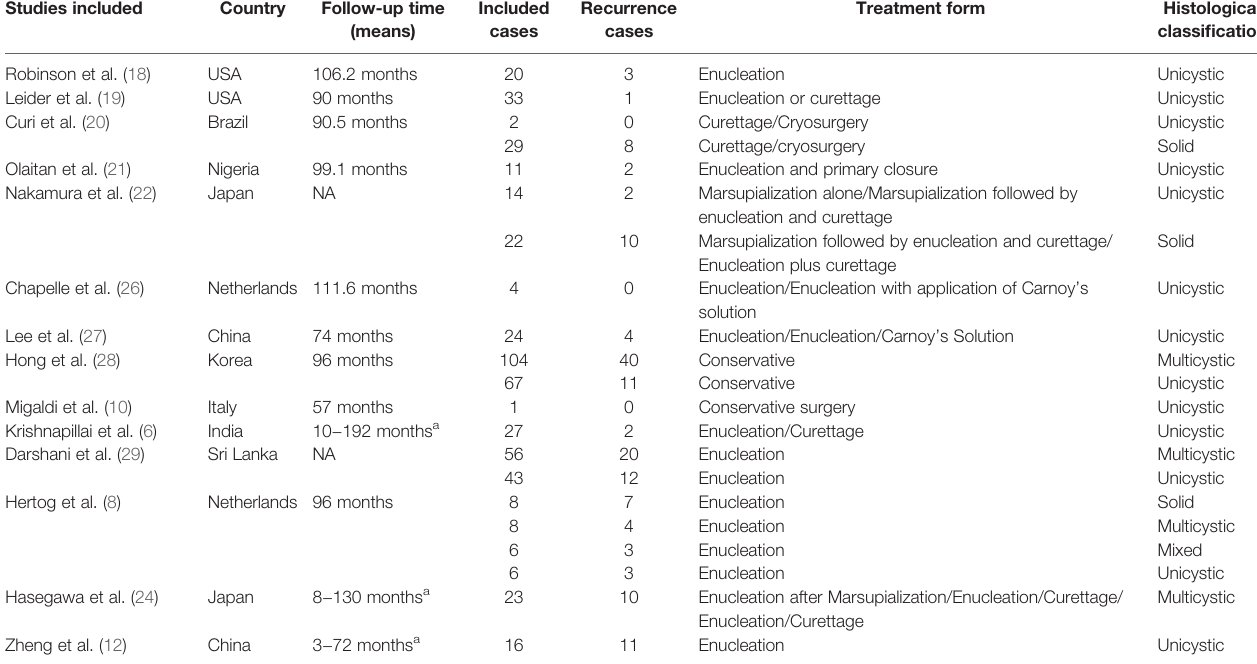
TABLE 1 | Study and participant characteristics with conservative